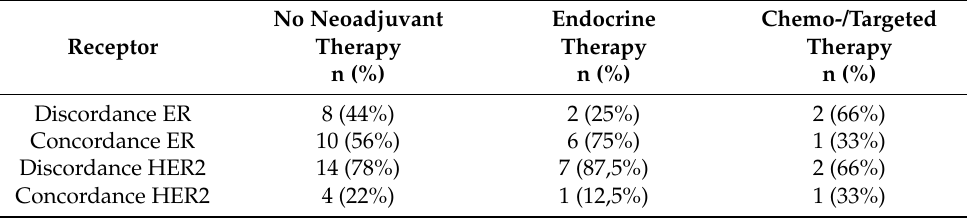
Table 5. Receptor discordance between DTCs and tumor tissue in patients without therapy, compared with patients receiving neoadjuvant endocrine therapy or neoadjuvant chemotherapy combined with targeted